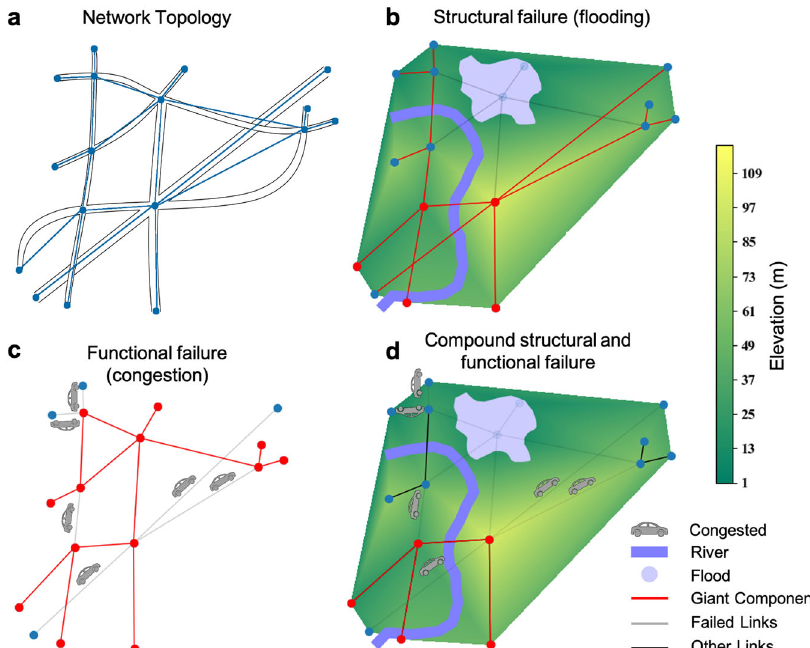
Fig. 1 Schematic diagram of fl ood impact on the transportation network. a Transportation network abstraction from roads to a graph with 19 links in total. b Transportation network in fl ooding (structural failure only, gray solid line). Low-elevation roads ( fi ve links) are fl ooded and marked as gray. The fourteen red links represent roads that are still connected to the giant component. c Transportation network in degraded service (i.e., congested) condition (functional failure only). Congestion here is de fi ned as the link quality drops below the critical threshold. When certain roads are congested (six links with cars), they are considered to have low service quality, and their corresponding links (gray links) are removed from the giant component. d Transportation network under both structural and functional failures. The congested (low link quality) and fl ooded roads (six congested and fi ve inundated) are marked as gray and removed from the network. The four black links represent the roads that are neither fl ooded nor congested but detached from the giant component.